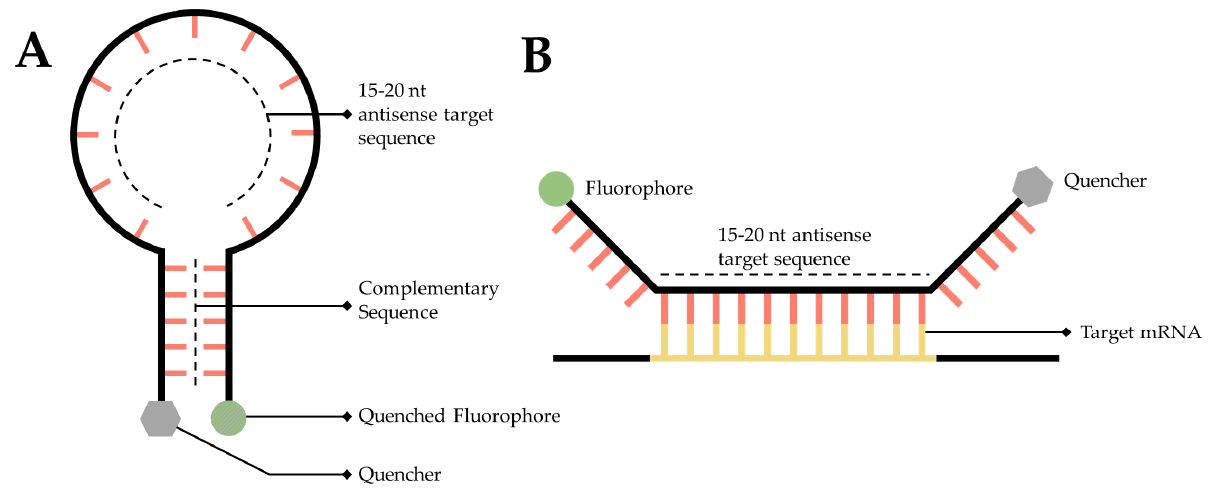
Figure 6. Simplified diagram of RNA molecular beacons. ( A ) A 15- to 20-nucleotide target sequence flanked by palindromic repeats causes the probe to form a stem-loop, bringing the quencher (Grey) and a fluorophore into close proximity causing the fluorophore to quench (Dark Grey). ( B ) When in close proximity to the target transcript, the target sequence will hybridize with the target mRNA, causing the stem-loop to open, moving the quencher and fluorophore away from one another, thereby facilitating fluorescence.